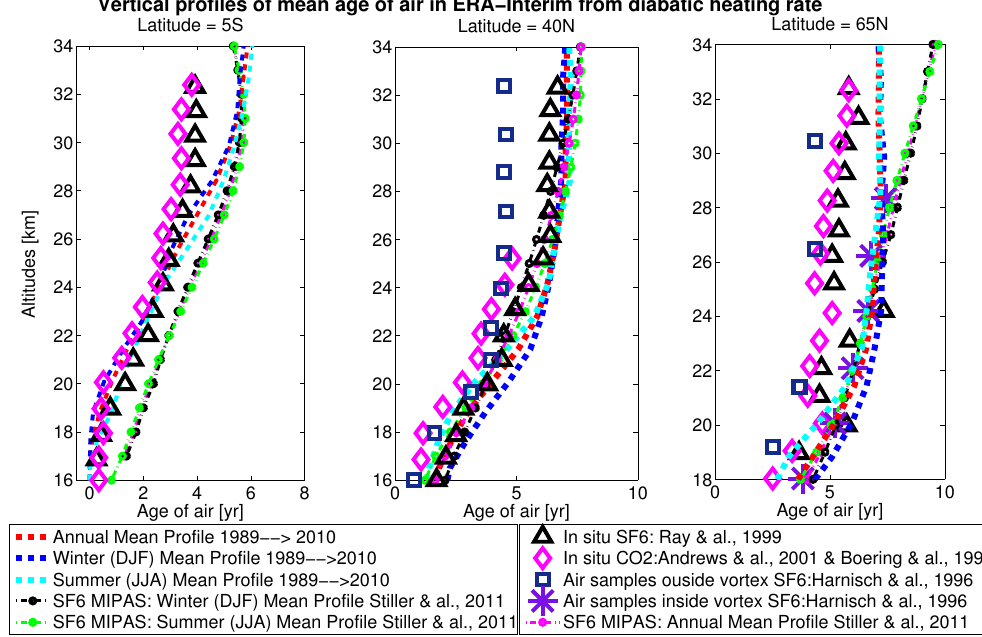
Fig. 6. (Dashed curves): vertical profiles of mean diabatic age (red: all year, blue: winter, cyan: summer). (Curves with circles): mean age profiles from SF 6 MIPAS (Stiller et al., 2012) (magenta: all year, black: winter, green: summer). (Symbols): in situ measurements of CO 2 (diamonds) (Boering et al., 1996; Andrews et al., 2001a), SF 6 (triangle) (Ray et al., 1999) and whole air samples of SF 6 (square outside vortex and asterisk inside vortex) (Harnisch et al., 1996).